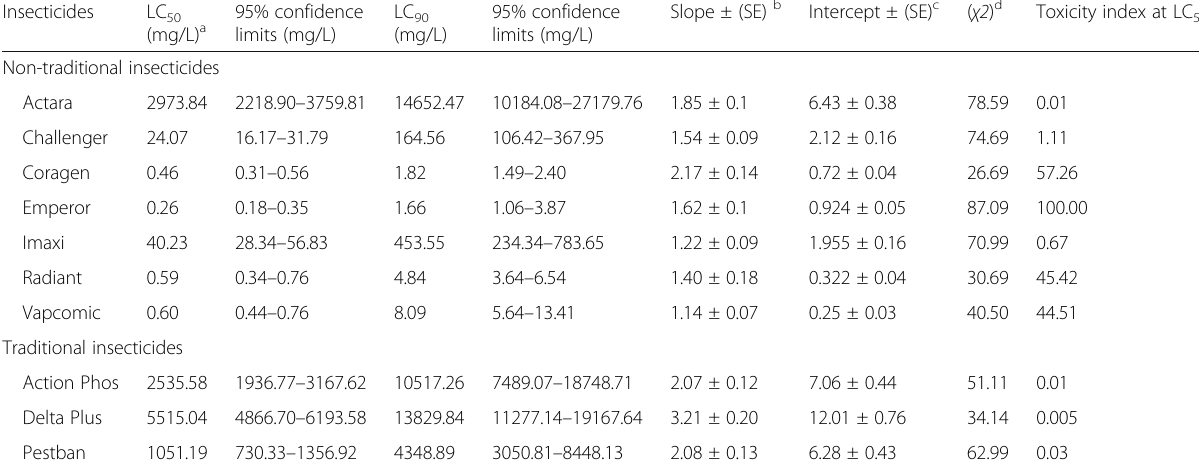
Table 4 Toxicity of tested insecticides against the 2nd instar larvae of Tuta absoluta